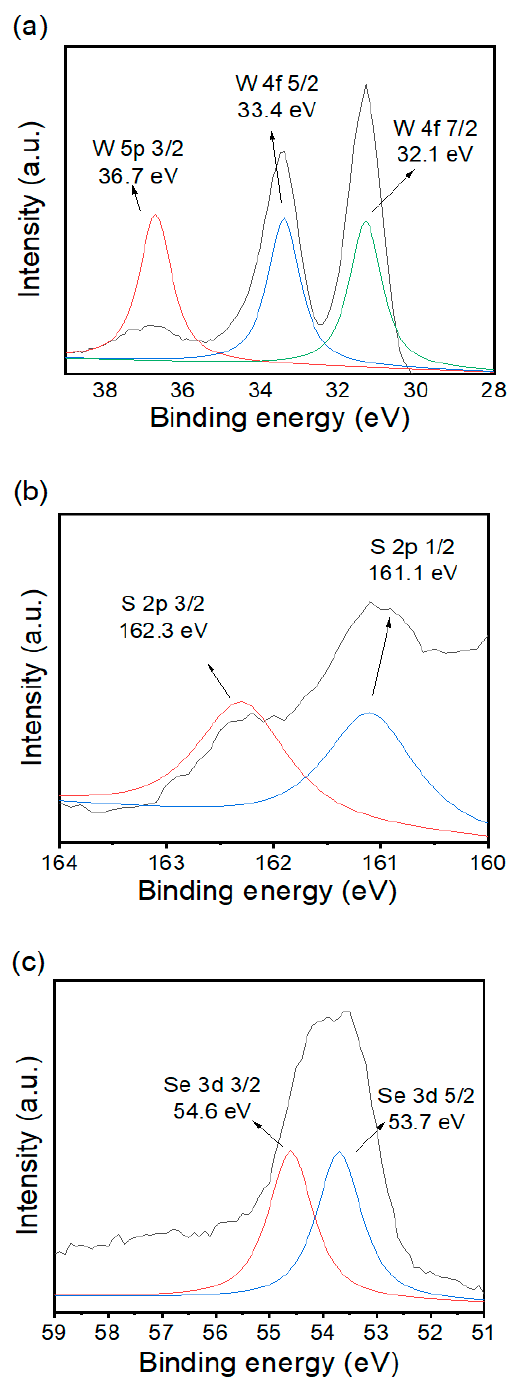
Figure 3. XPS survey spectra of WS 2 /WSe 2 . High-resolution XPS spectra of the ( a ) W 4f, ( b ) S 2p, and ( c ) Se 3d.